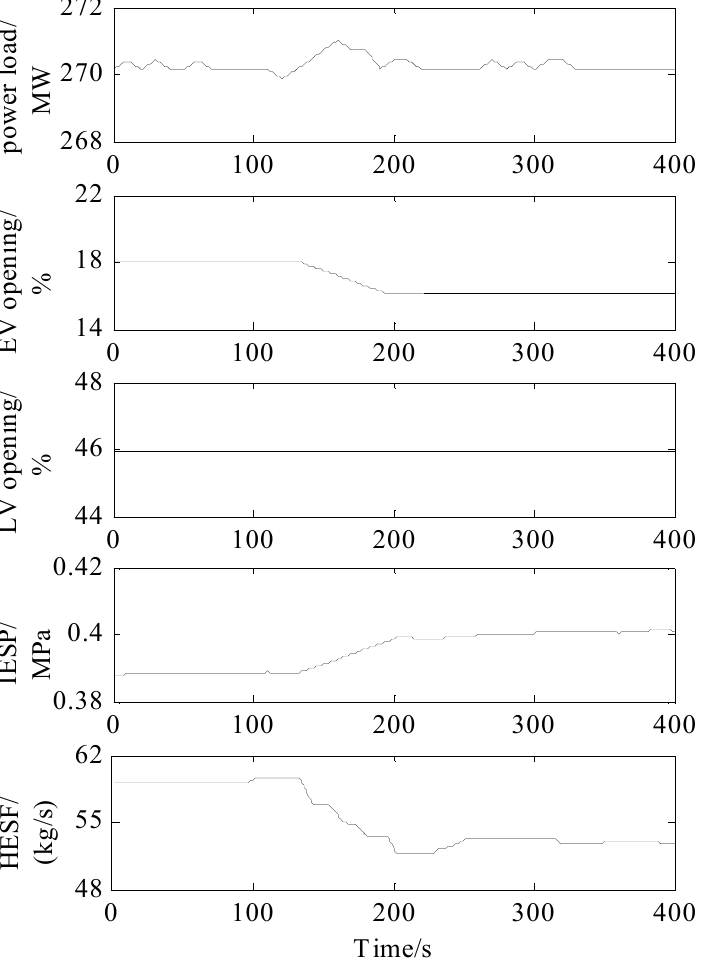
Figure 5. Dynamic response to LV opening. Figure 6 (all pressure used is gauge pressure) shows the curves of the soft-sensing value of the HEXTR flow rate and the change curves of relative parameters when the unit